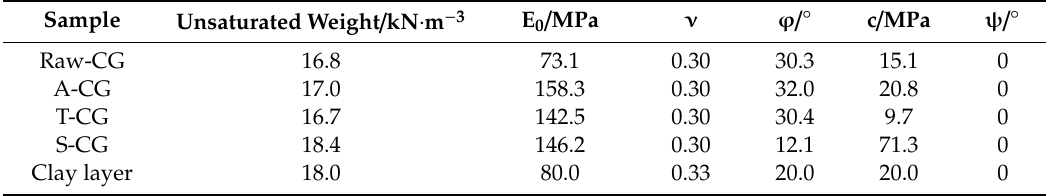
Table 2. Material parameters used in the